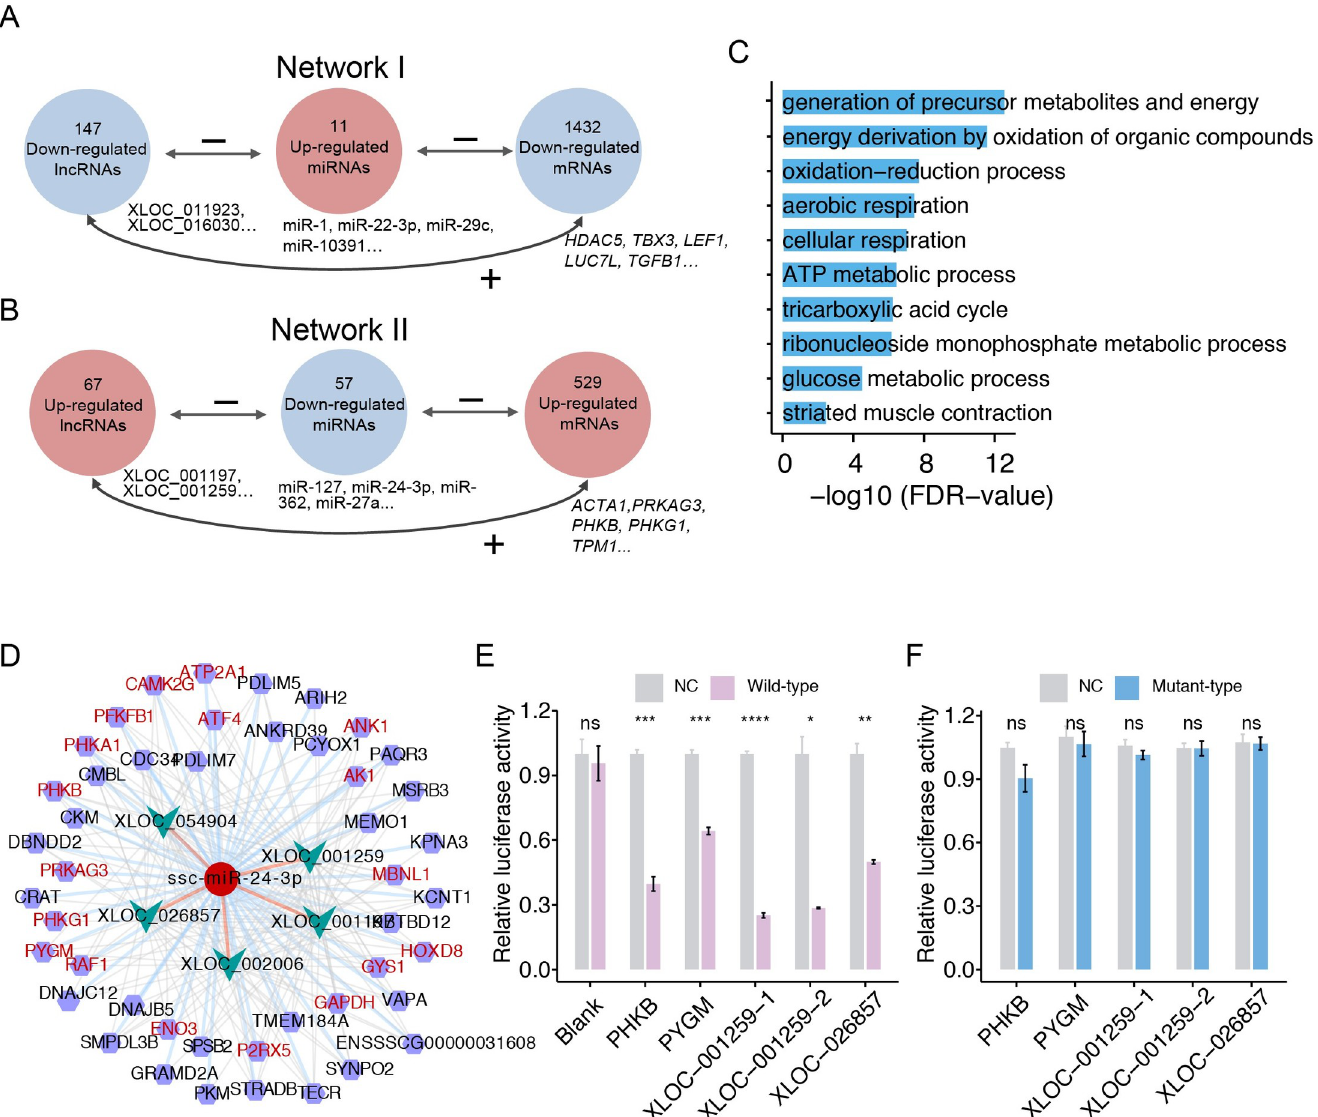
Fig 3. LincRNA-miRNA-mRNA regulatory network during skeletal muscle development. ( A, B ) Schematic diagram representing the lincRNAs-miRNA-mRNA axes that satisfied our criteria. “-” represents the negative correlation between the expression of lincRNAs/mRNAs and miRNAs. “+” represents the positive correlation between the expression of lincRNAs and mRNAs. The correlations are performed by Pearson’s correlation tests. ( C ) GO enrichment analyses of the mRNAs in network I. ( D ) Cytoscape showing the miR-24-3p involved lincRNA-miRNA-mRNA interactions, five lincRNAs and 40 mRNAs are targeted by miR-24- 3p in this sub-network. The ellispe (dark red), arrow (turquoise), and hexagon (purple) nodes represent miR-24-3p, lincRNAs and mRNAs, respectively. mRNAs that are known to be involved in insulin signaling pathway are marked in red. The dark orange, light sky blue and grey edges represent the interactions between miR-24-3p and lncRNAs, between miR-24-3p and mRNAs, and between lincRNAs and mRNAs, respectively. ( E, F ) Validation of the targets of miR-24-3p by dual-luciferase reporter assay. Pig SkMCs were co-transfected with luciferase reporters carrying the wild-type ( E ) or mutated 3 0 -UTR ( F ) of four target genes ( PHGB , PYGM , XLOC- 001259 , and XLOC-026857 ), as well as their corresponding miR-24-3p mimic/negative control duplexes. The data are represented as mean ± S.E.M (n = 3). � P < 0.01. �� P < 0.01. ��� P < 0.001. ���� P < 0.0001. ns, no significant.